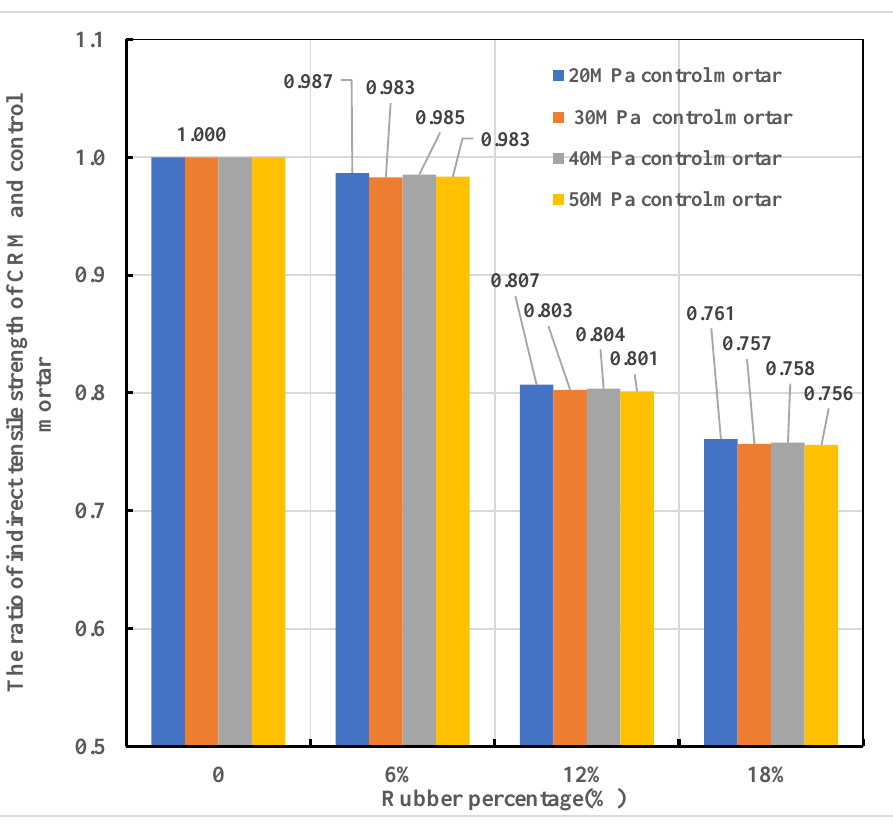
Figure 15. Changes in indirect tensile strength of CRM with different rubber contents.